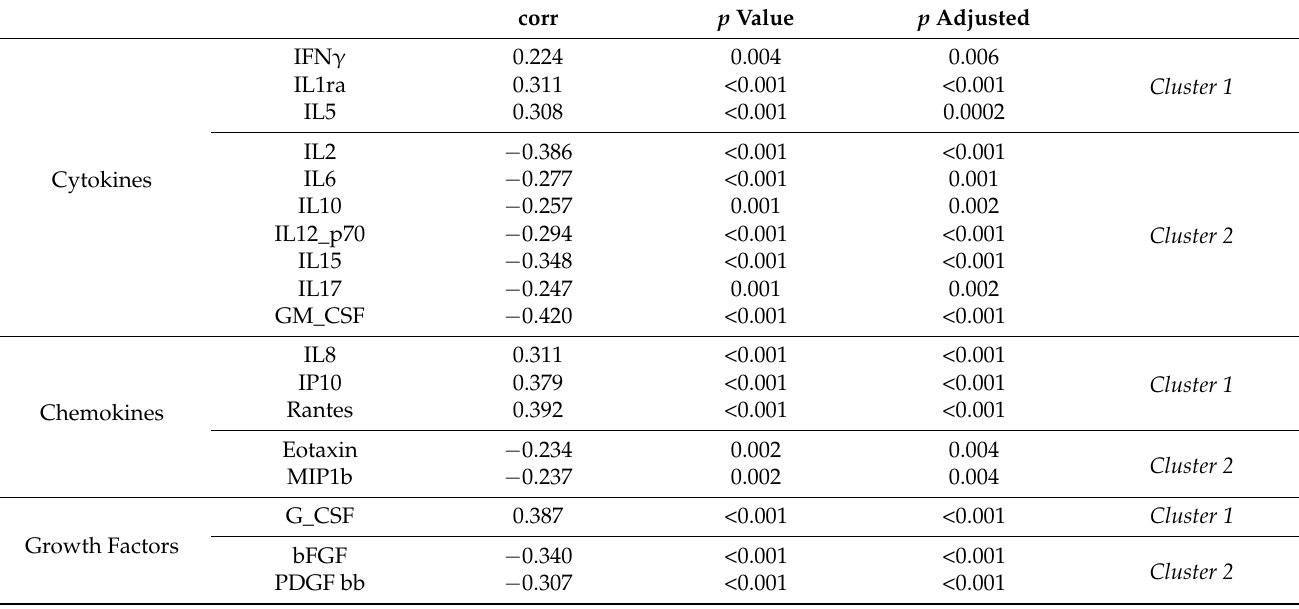
Table 2. Correlation between the levels of let-7b-5p and biochemical factors circulating in the CSF of patients with MS at T0. p Value p